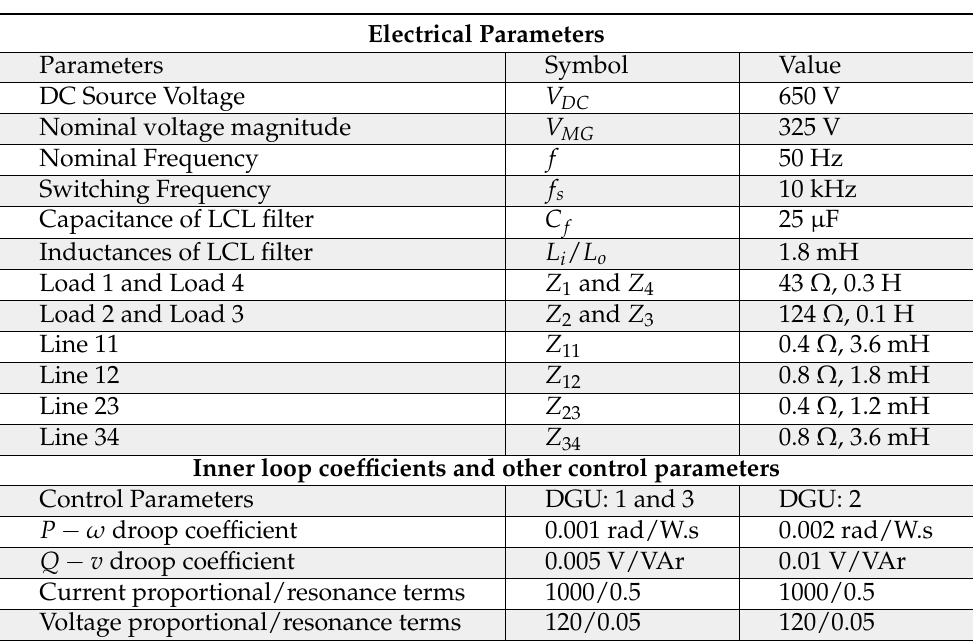
Table 1. Parameters of the test system.